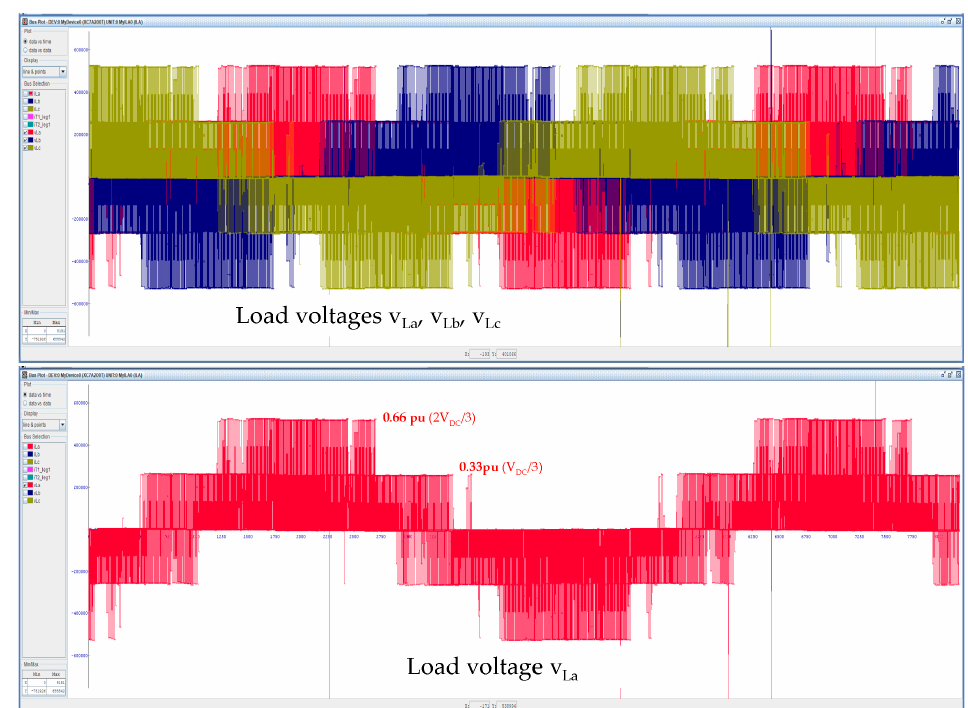
Figure 6. RT results for the three-phase VSI—Output voltages.